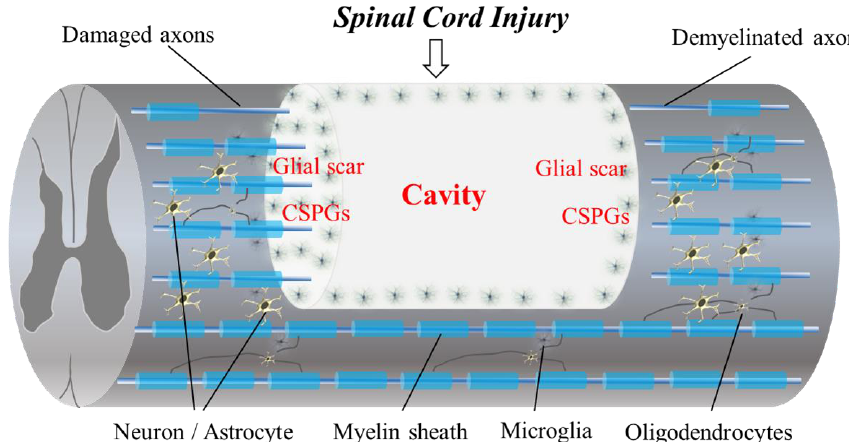
Figure 1. The diagram shows the pathophysiological events in SCI. Progressive demyelination results in the degeneration of axonal fibers. A cavitation occurs in the epicenter. Hypertrophic astrocytes with very long processes over the tips of non-regenerating fibers form a barrier known as a glial wall around the cavitation. In response to injury, microglial cells transform into active phagocytic microglia and exhibit chemotaxis. The presence of CSPGs creates an inhibitory environment for axonal regeneration. In addition, CSPG also inhibits the migration and differentiation of oligodendrocyte progenitor cells.